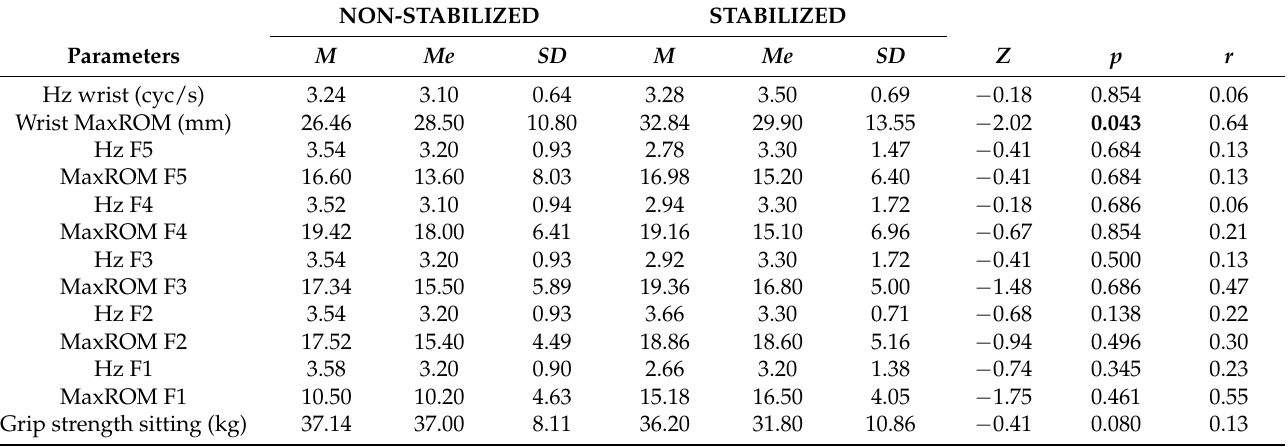
Table 8. Comparison of the results of parameters in the unstable and stabilized position for the age group of 18–45 years of healthy